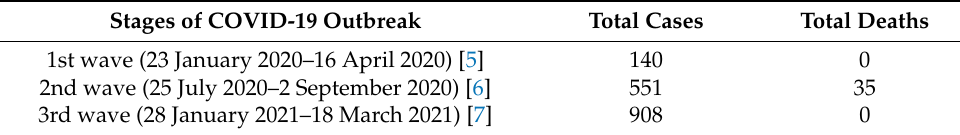
Table 1. COVID-19 domestic infection cases in Vietnam by the waves of outbreaks. Stages of COVID-19 Outbreak Total